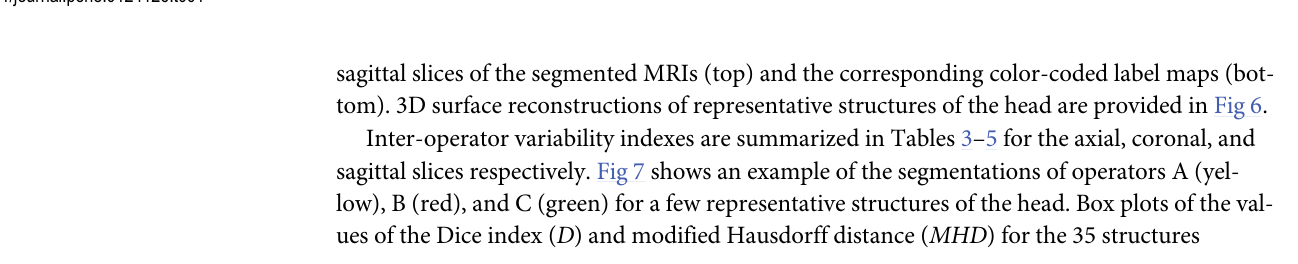
sagittal slices of the segmented MRIs (top) and the corresponding color-coded label maps (bot- tom). 3D surface reconstructions of representative structures of the head are provided in Fig 6. Inter-operator variability indexes are summarized in Tables 3 – 5 for the axial, coronal, and sagittal slices respectively. Fig 7 shows an example of the segmentations of operators A (yel- low), B (red), and C (green) for a few representative structures of the head. Box plots of the val- ues of the Dice index ( D ) and modified Hausdorff distance ( MHD ) for the 35 structures